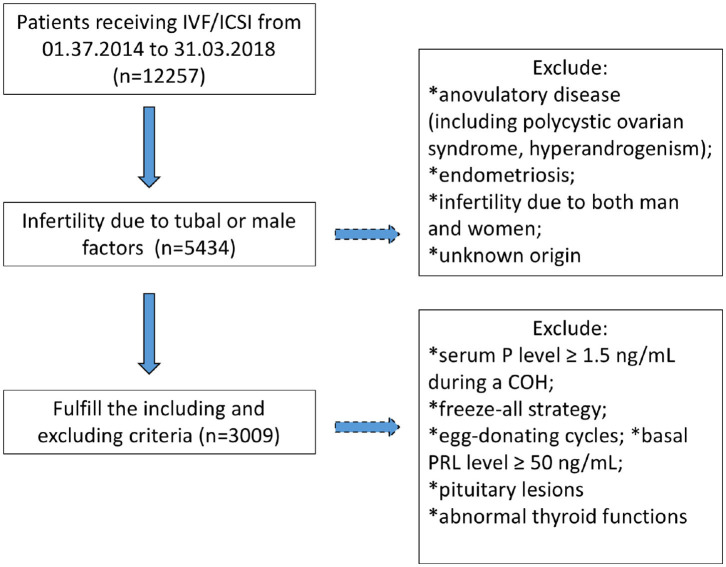
Flowchart regarding patients' inclusion and exclusion. COH, controlled ovarian hyperstimulation; P, progesterone; PRL, prolactin.